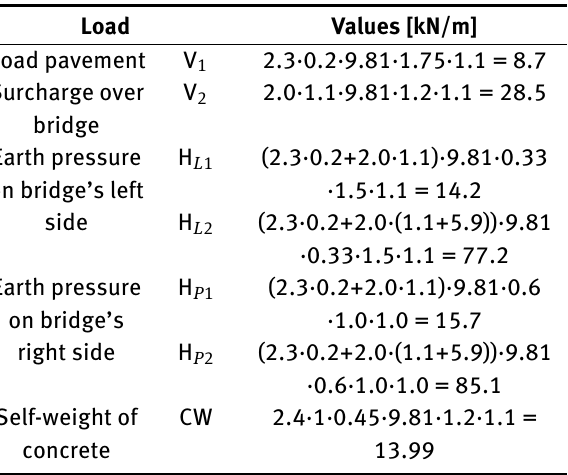
Figure 7: Load denotations and load action directions Table 4: Permanent load